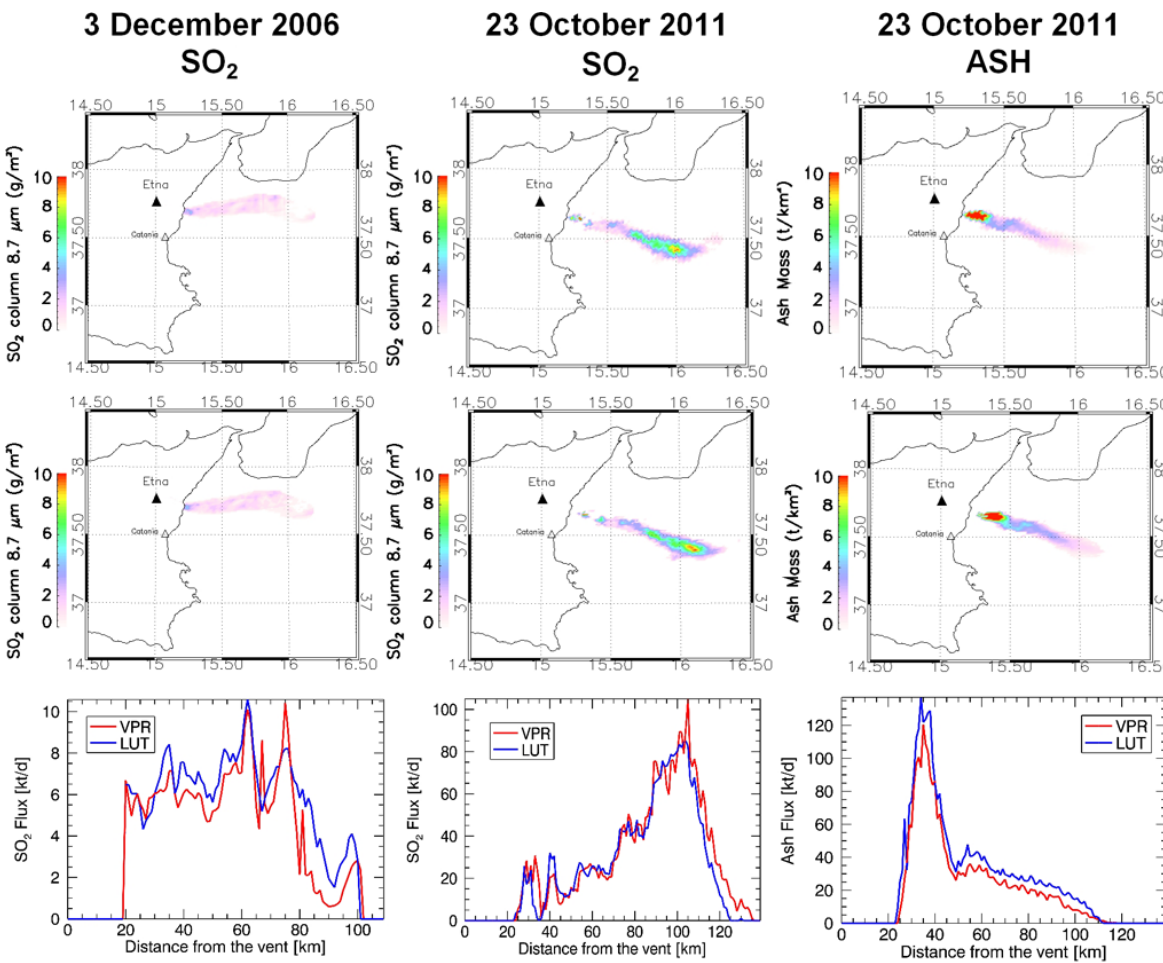
Fig. 9. SO 2 and ash assessments using the VPR (upper plates) and LUT (middle plates) procedures for the two Etna events considered. The lower plates show the flux